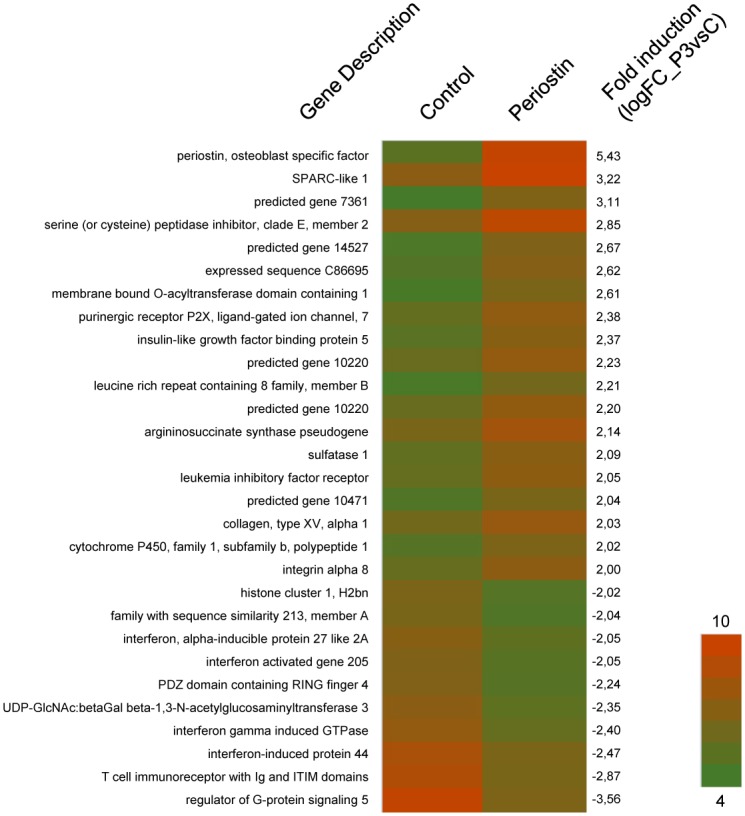
Microarray analysis in MC3T3-E1 periostin overexpressing cells and control MC3T3-E1 cells.Heat map represents the relative expression levels of selected genes (logFC2_P3vsC) as determined by hybridization with GeneChip Mouse Gene 2.0 Array. Left column indicates gene name and Right column indicates logFC_P3vsC value.